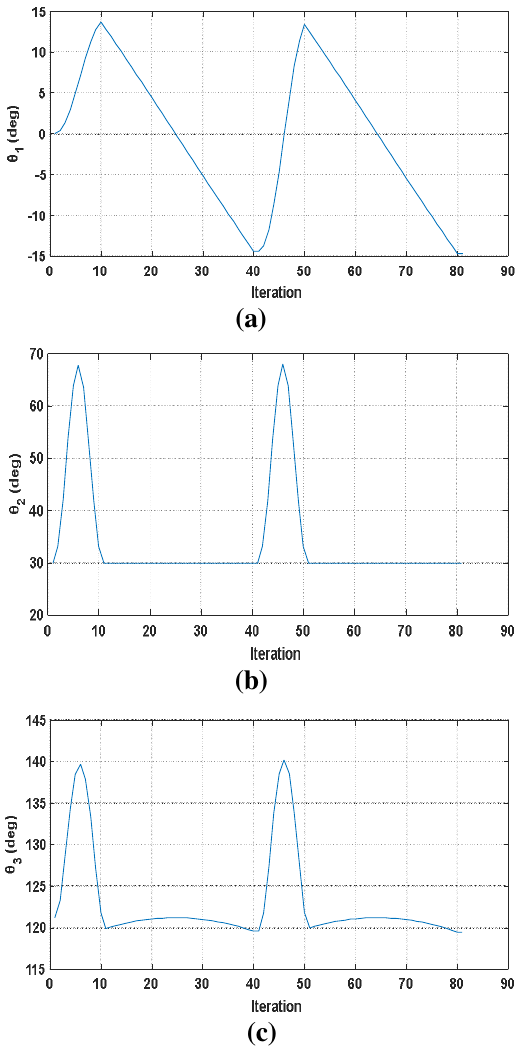
Fig. 21. changing of angles (a) Coxa-angle (b) Femur-angle (c)